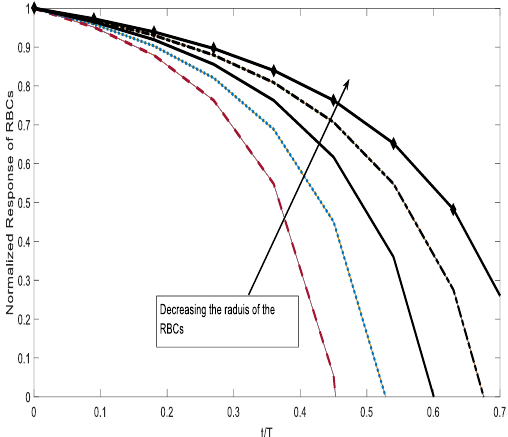
Fig.3: Response of SAW with different volume fractions. The same volumes of the RBCs but with different volume fractions From the modelling equations, different volume fractions means different time responses of the SAW sensor as shown in Fig.4.